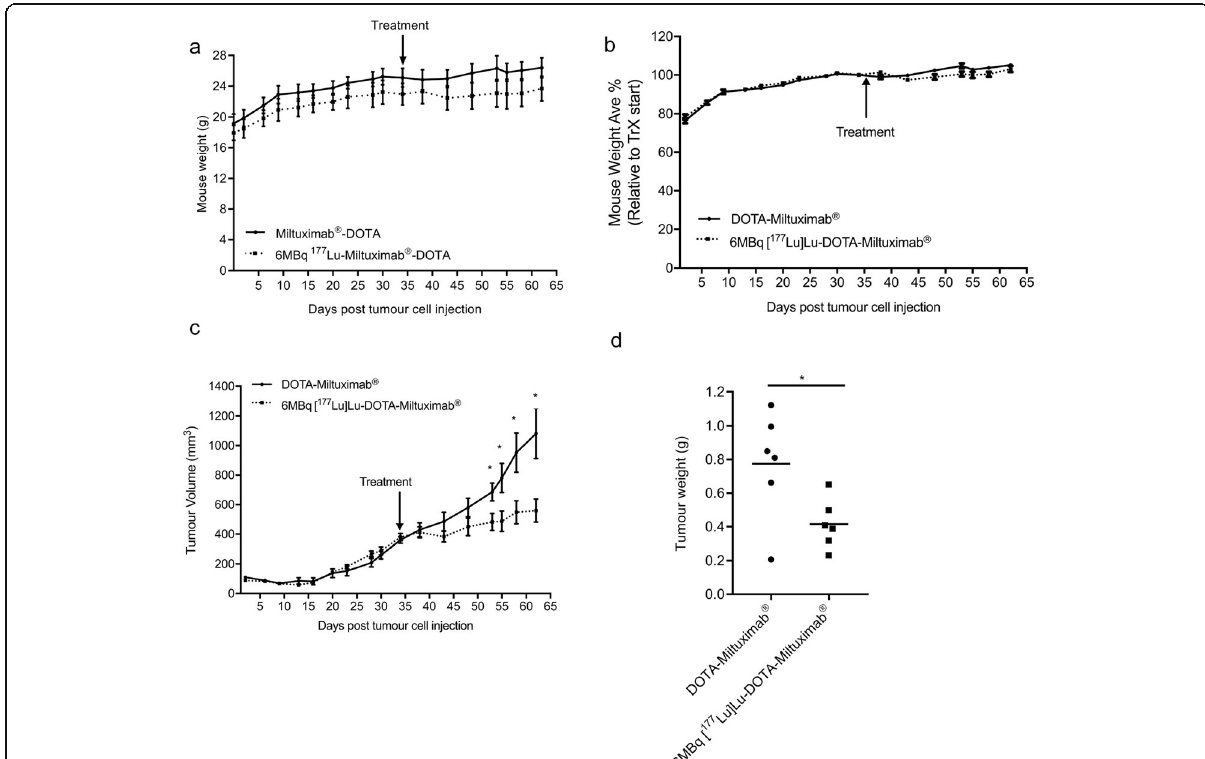
Fig. 3 Inhibition of DU-145-RFP-Luc xenograft growth by 6 MBq [ 177 Lu]Lu-DOTA-Miltuximab® in vivo. DU-145-RFP-Luc cells (5 × 10 6 ) in Matrigel were injected subcutaneously into the right flank of BALB/c/nude mice. On day 34 post tumour cell inoculation, BALB/C/nude mice bearing DU- 145-RFP-Luc xenografts were injected with DOTA-Miltuximab® ( n = 6) or 6 MBq [ 177 Lu]Lu-DOTA-Miltuximab® ( n = 6) intravenously. Mice were weighed and tumour volumes were measured twice weekly via callipers. a Average mouse body weight over time. b Percentage mouse body weight relative to start of the treatment. c Mean weekly mouse tumour volume. Day 53, * p = 0.0353; 55, * p = 0.0358; 58, * p = 0.0255; 62, * p = 0.0191. d Individual mouse tumour weights at endpoint. Data expressed as mean ± SEM and statistical analysis performed using an unpaired t test. * p <